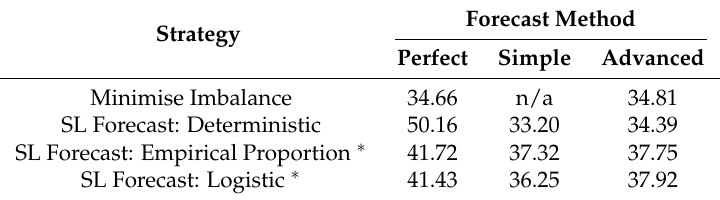
Table 2. Normalised revenue (£/MWh) using different trading strategies. For strategies marked ∗ “Forecast Method” refers to the type of price forecast only. The mean day-ahead price during the test period was